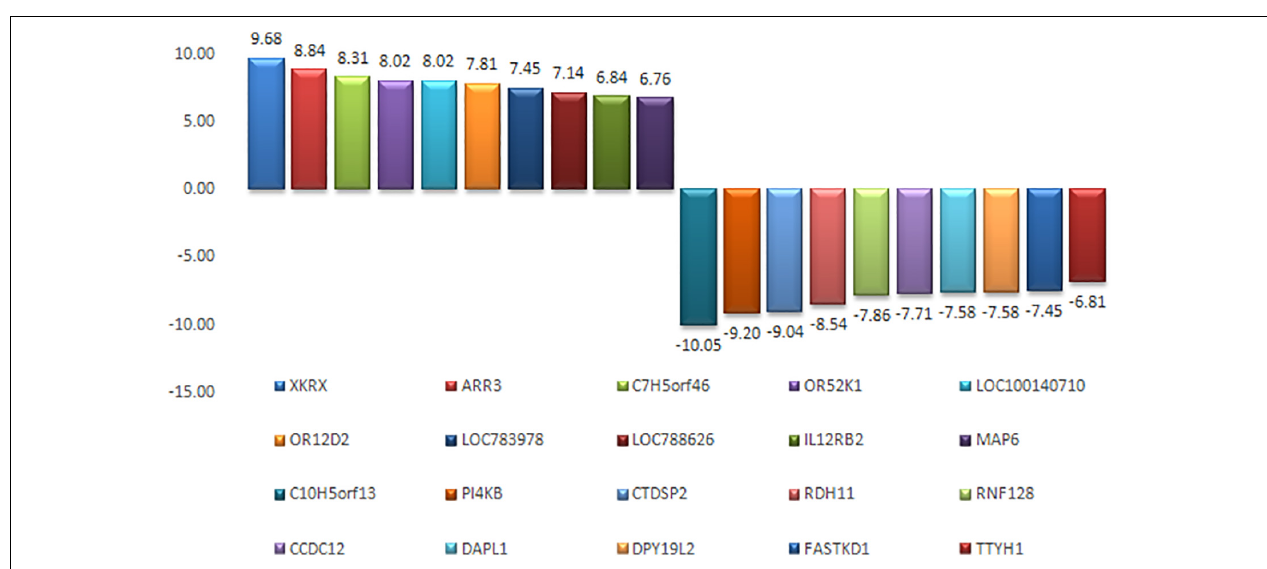
FIGURE 4 | Top 10 upregulated and top 10 downregulated transcripts in crossbred bull testes as compared to indigenous bull testes (from Elango et al.,